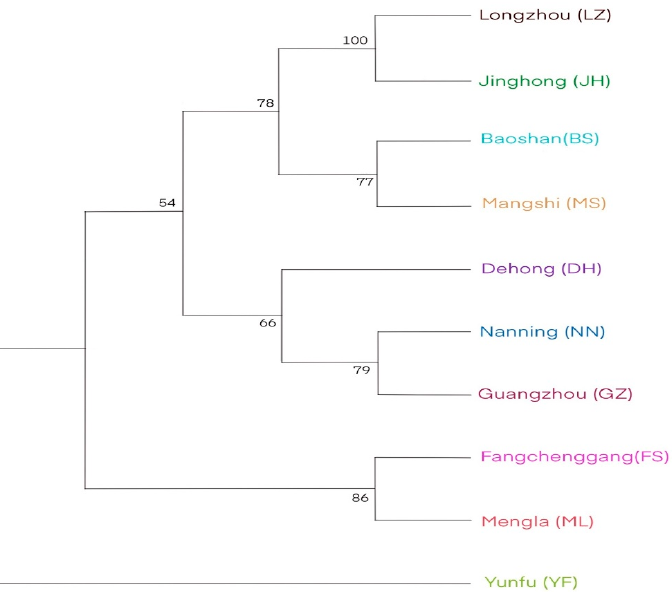
Figure 5. Phylogenetic relationships among ten populations of N. cadamba derived from the haploid nrDNA ITS markers. The phylogenetic tree was drawn using the ML method with 1000 bootstrap resamples.